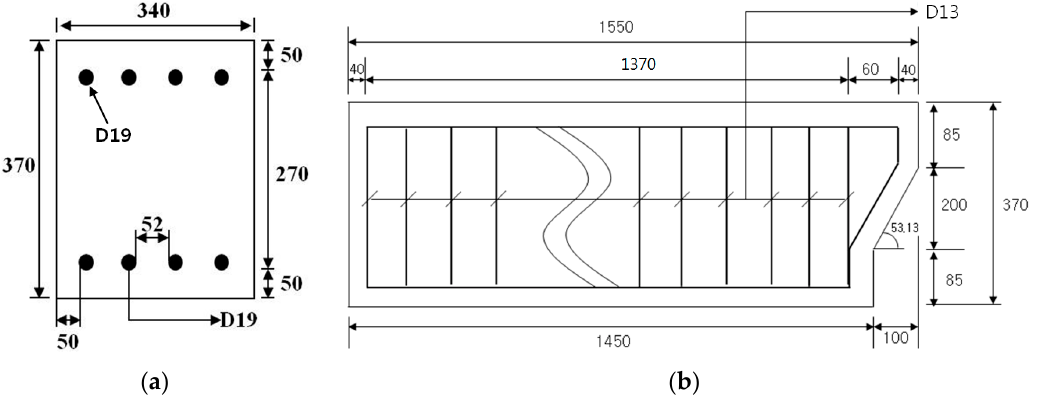
Figure 8. Rebar layout (unit: mm): ( a ) cross-section view; and ( b ) plan view.